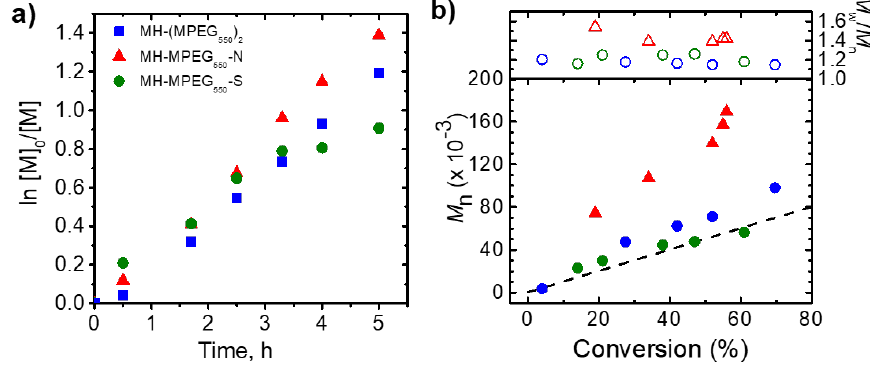
Figure 4. First-order kinetic plots ( a ), evolution of MW and dispersity with conversion ( b ) for entry 7-9 in Table 1.